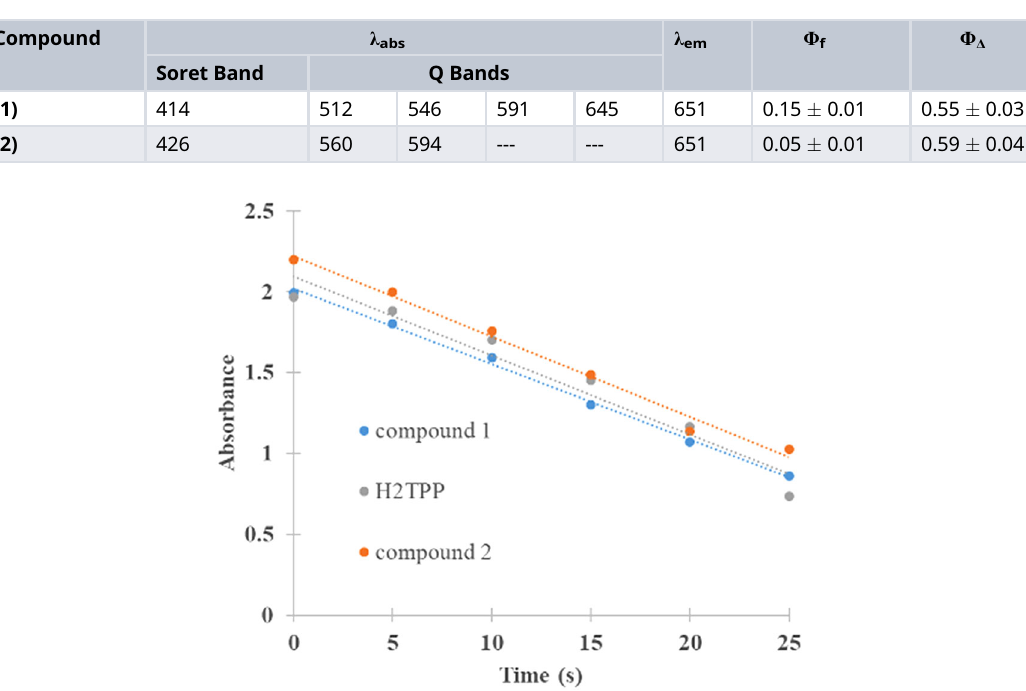
Table 1. Photophysical properties ( Փ f y Փ Δ ) of ( 1 ) and ( 2 ).